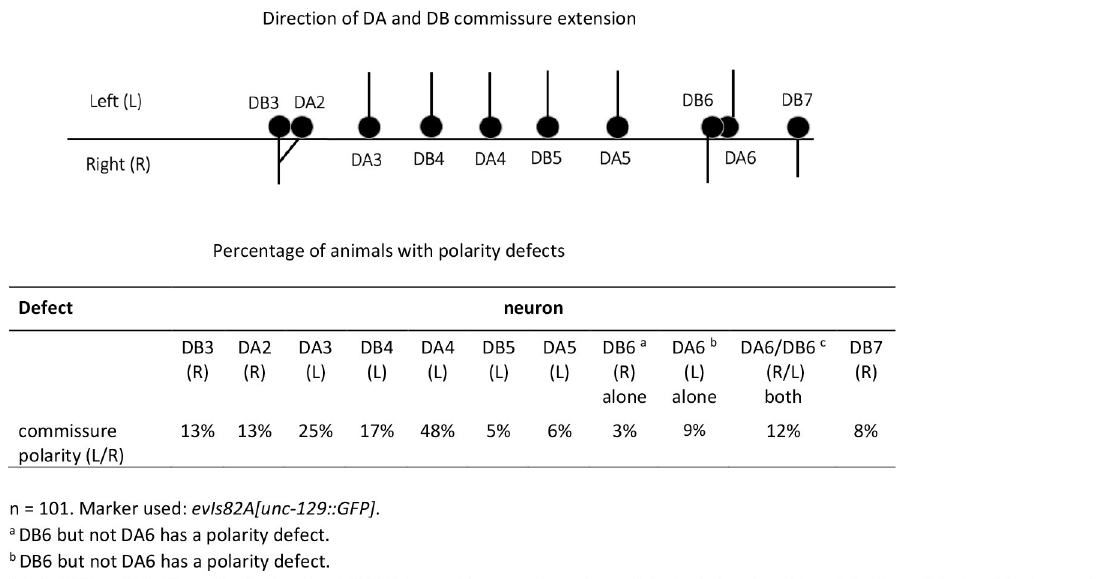
Fig 5. Polarity defects in individual DA/DB motoneuron commissures in lron-11(ok2333) mutants. The top part shown the direction of commissure extension (left or right) for individual DA and DB commissures. The table shows the percentage of animals, where commissures grow out on the wrong side, suggesting a left/right polarity defect of the neuron.